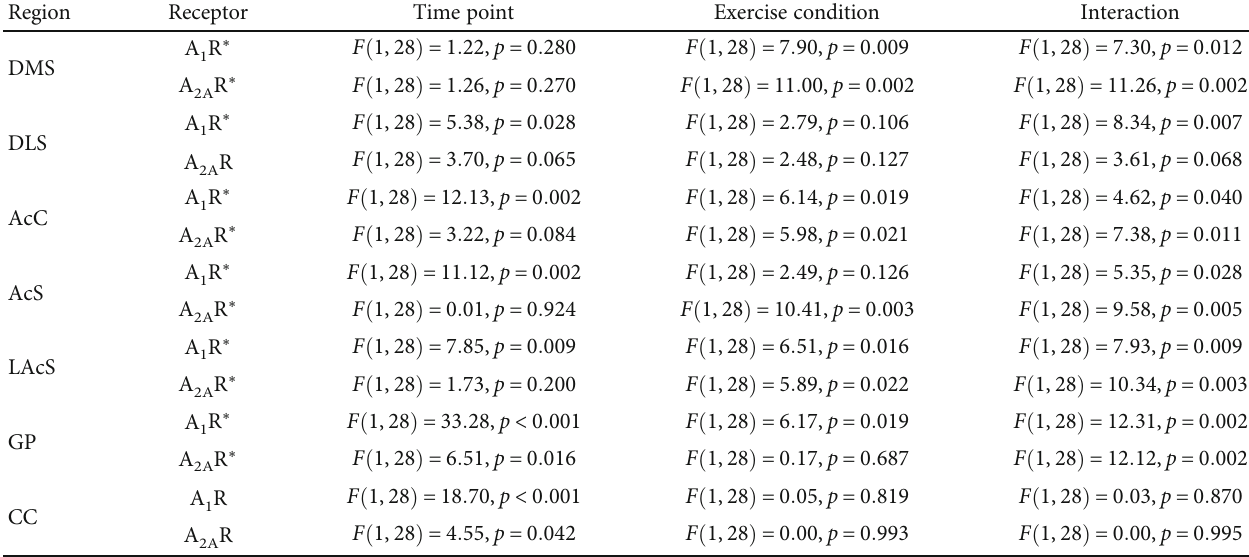
Table 2: List of ANOVA results for adenosine 1 and adenosine 2A receptor protein density in striatal subregions. ∗ p < 0 : 05 interaction between time point and condition. Region Receptor Time point Exercise condition